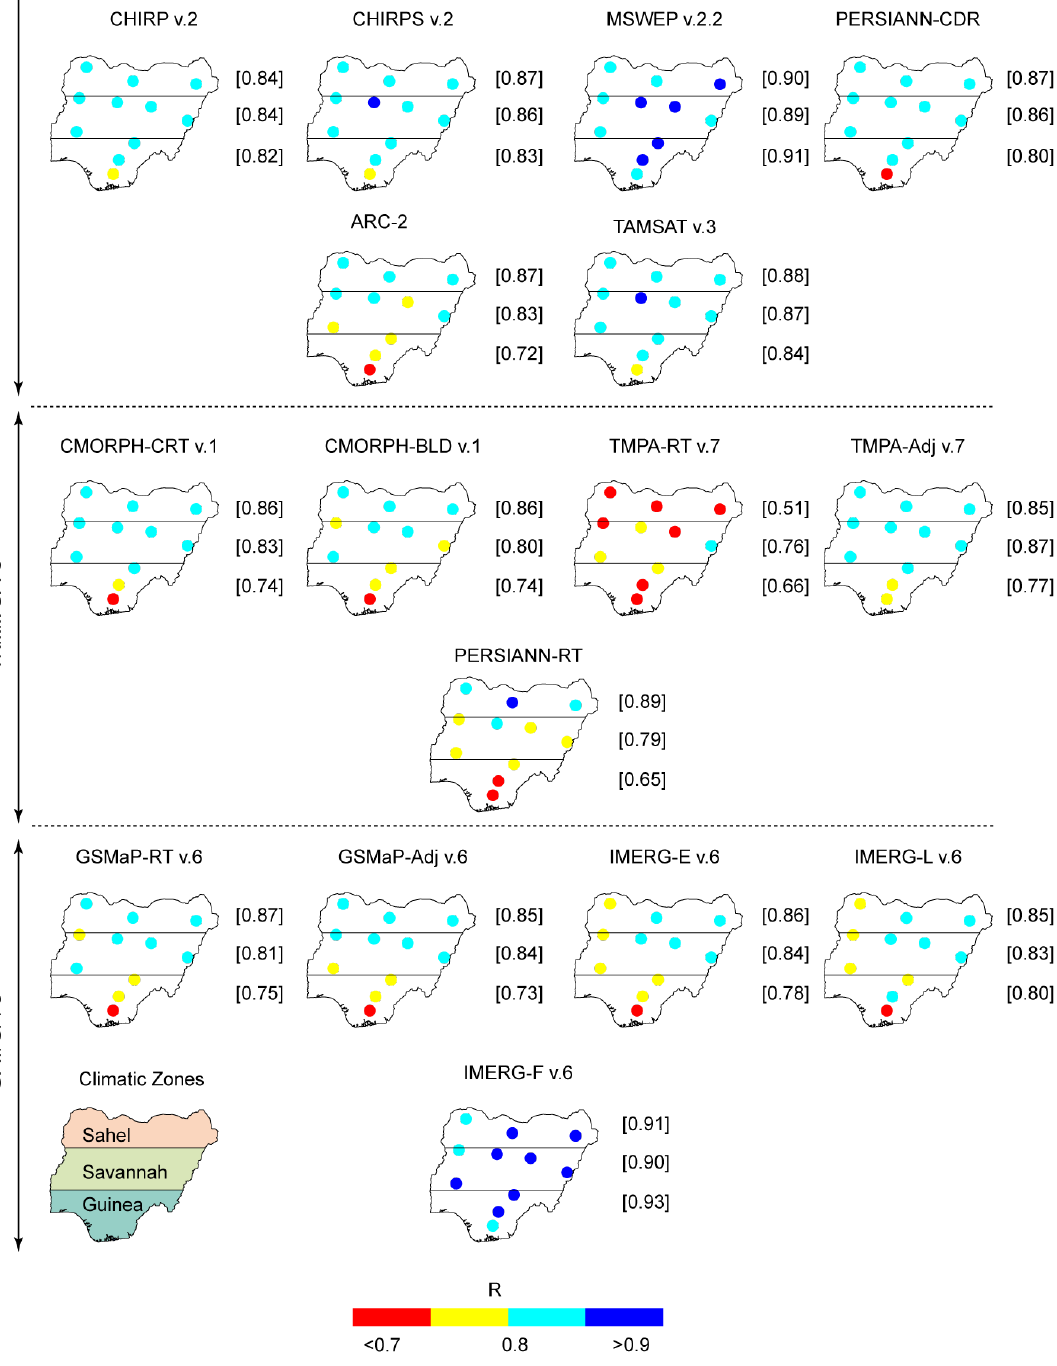
Figure 5. R scores obtained at the grid cell level of all the SPPs corresponding to gauge stations in the period 2000–2012. The SPPs are grouped according to their respective categories, and the gauges are separated by the country’s ecological zones. Values in brackets are the average of the scores obtained inside the same ecological zone.